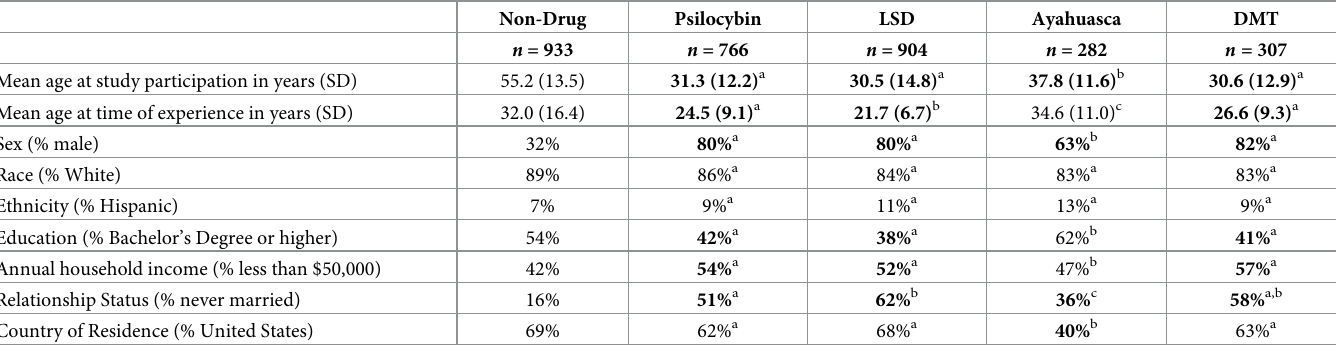
Table 2. Participant characteristics for Non-Drug, Psilocybin, LSD, Ayahuasca, and DMT groups 1,2 .